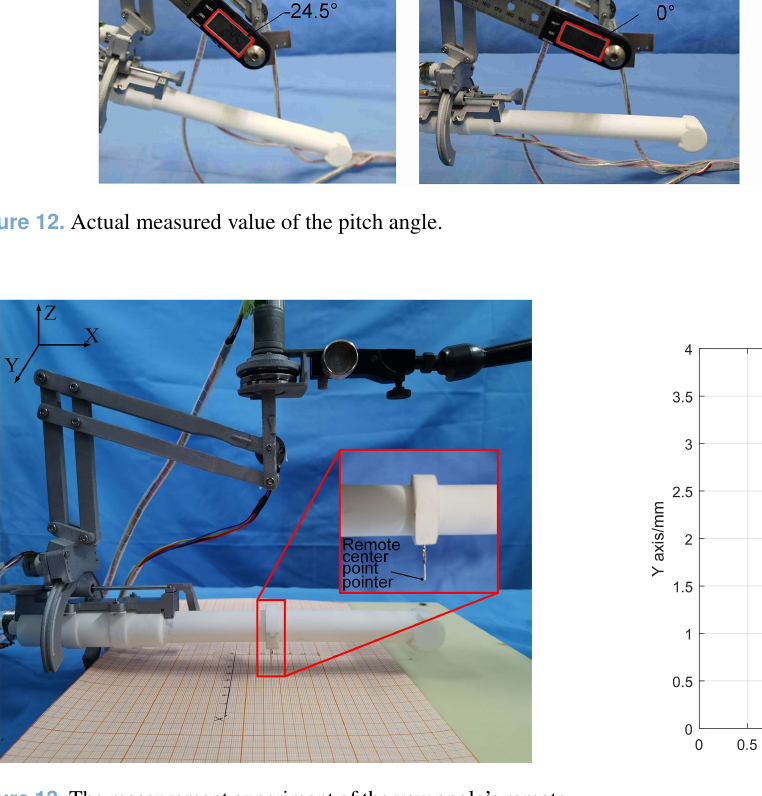
Figure 13. The measurement experiment of the yaw angle’s remote center point.